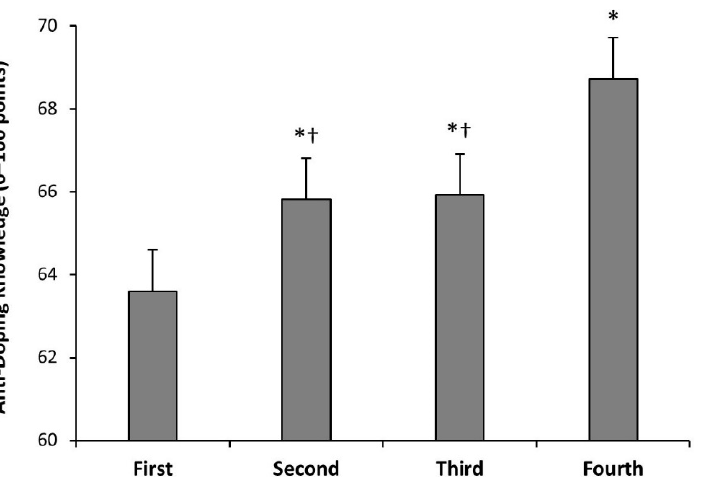
Figure 3. Scores in the adapted version of the WADA Play True Quiz of students undertaking a degree in sports sciences in Spanish universities according to their course. Data for each course are presented as mean ± standard deviation. (*) Different from students in the first course at p < 0.050, identified with Tukey post hoc. (†) Different from students in the fourth course at p < 0.050, identified with Tukey post hoc.